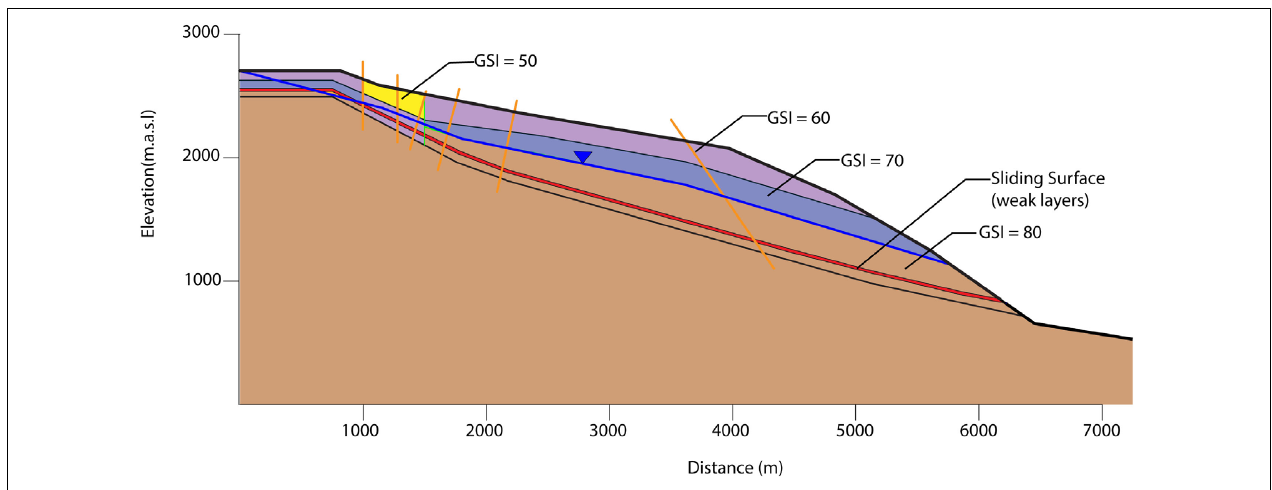
FIGURE 5 | Example of geometry and material properties of a GSI model in Phase2. Orange lines indicate discrete fault locations and the expected sliding surface, shown in red, is modeled either as disintegrated Quintnerkalk or a marl-like layer in all models. The blue line represents the assumed groundwater table position (about 100–300 m above the failure surface) in the “wet”